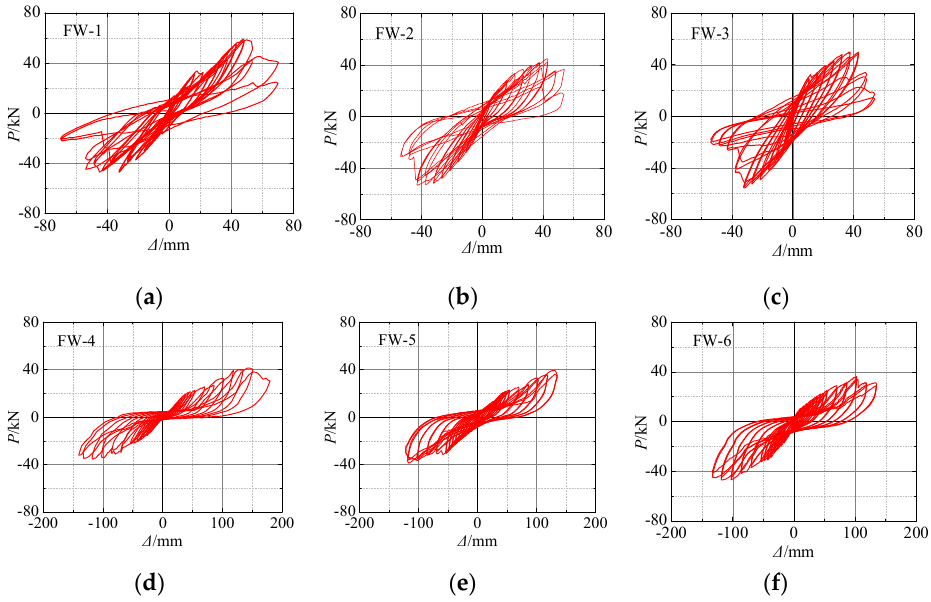
Figure 12. Hysteretic curves: ( a ) FW-1 specimen; ( b ) FW-2 specimen; ( c ) FW-3 specimen; ( d ) FW-4 specimen; ( e ) FW-5 specimen; ( f ) FW-6 specimen.